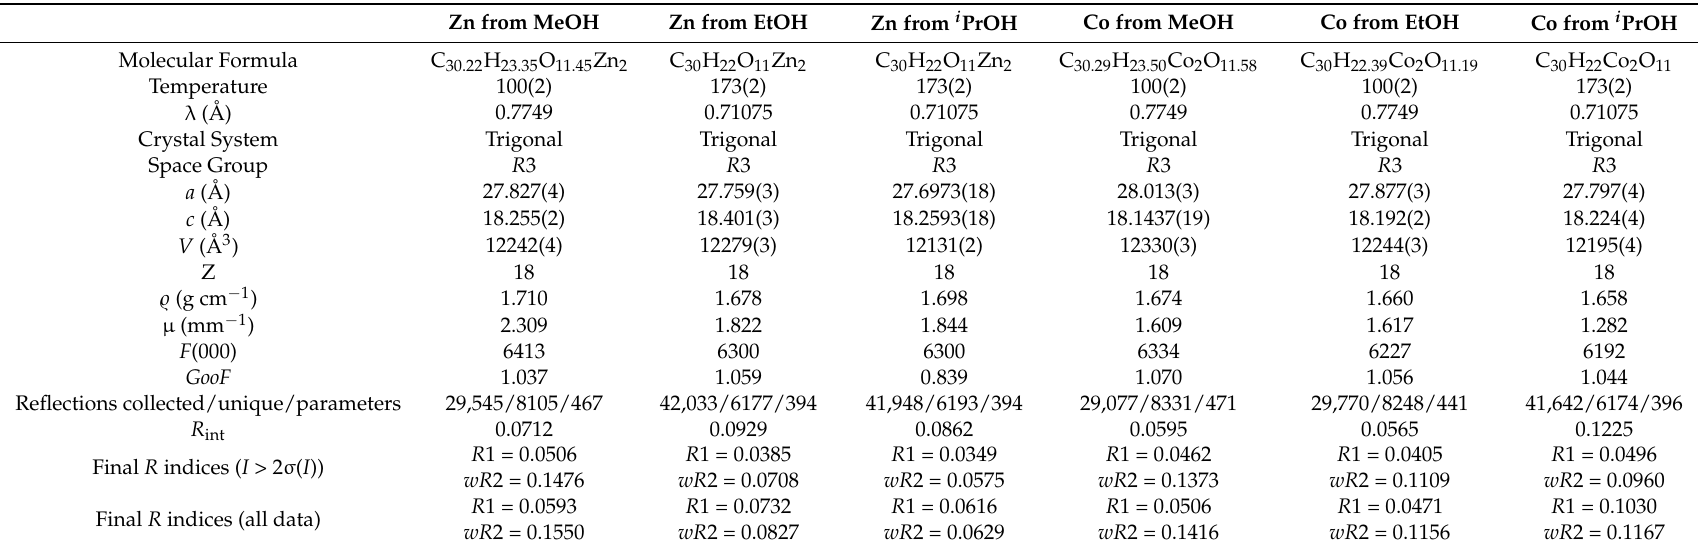
Table 1. Crystallographic data for the first run of the various M 2 (BzOip) 2 (H 2 O) crystals. Zn from MeOH Co from EtOH Co from i